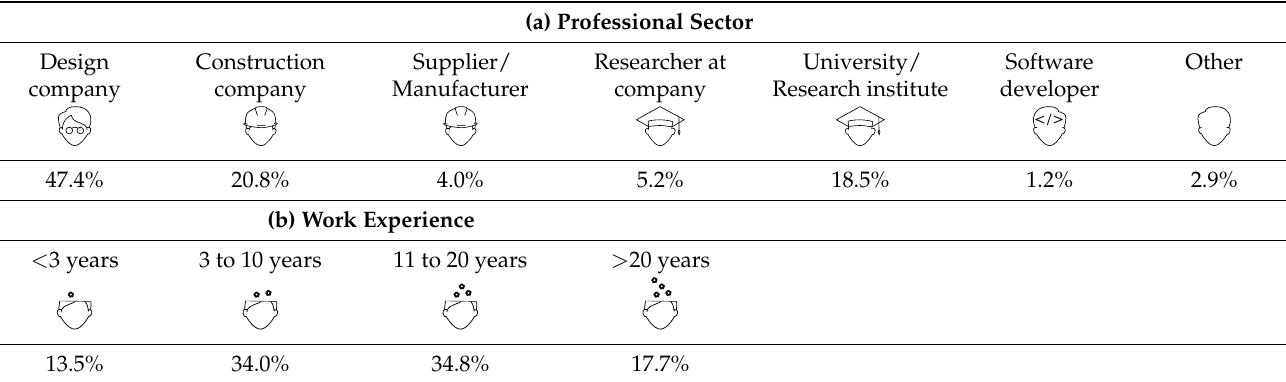
Table 1. Profile of the participants (single choice).